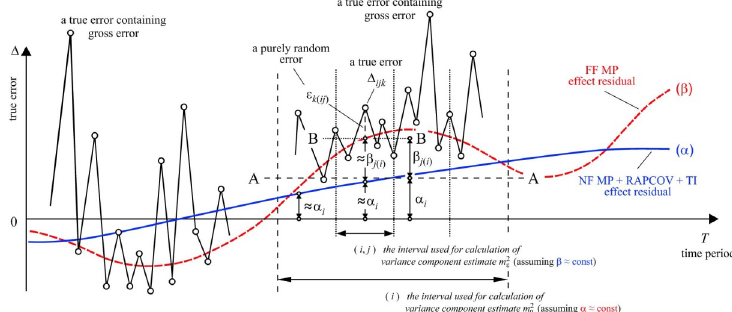
Figure 1. The concept of the method applied herein (adapted from Figure 6.3.1 in Anđić,